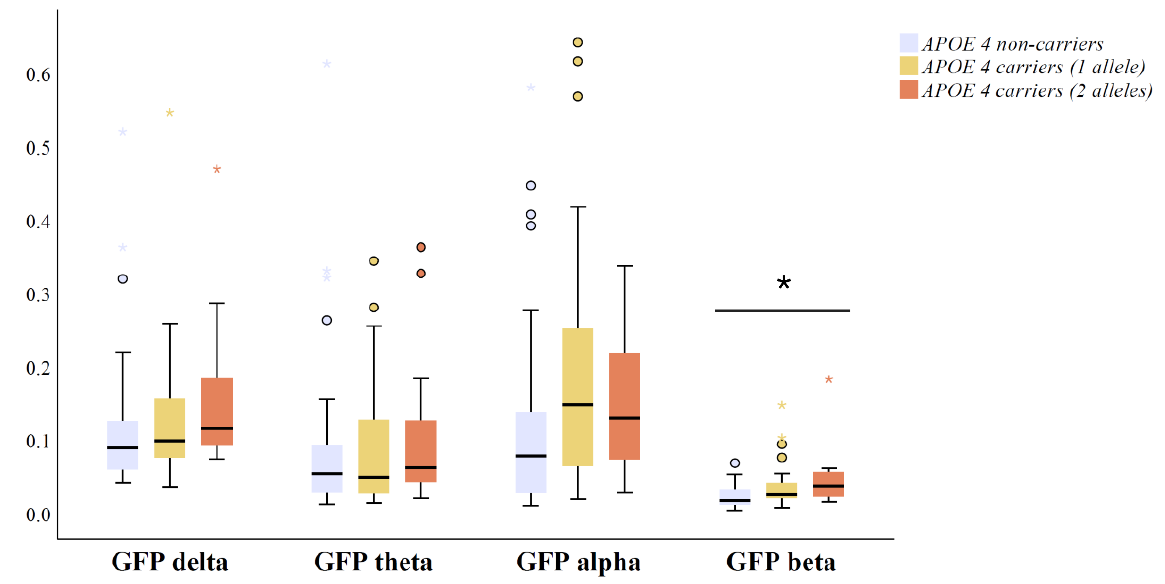
Figure 1. Differences in qEEG measures of global field power (GFP) between APOE ε4 carriers with two alleles ( n = 28), carriers with one allele ( n = 42) and non-carriers ( n = 31) including CSF Aβ42 positive (<550 ng/l) MCI and AD patients. The original data on GFP are presented as the median (solid line), interquartile range (box), and minimum and maximum values (whiskers) across four conventional frequency bands. p -values are based on ANOVA over the three genotype groups using GFP measures transformed with zero skewness natural log-transformation; * p < 0.05. Outlier and extreme values are denoted as circles and stars, respectively. Abbreviations: ANOVA = analysis of variance; and APOE = apolipoprotein E.